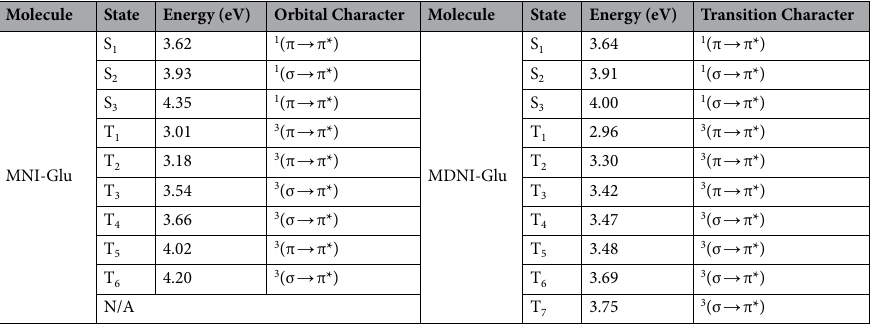
Table 2. Details of the excitation types for the singlet and triplet states in the experimental range (250– 500 nm) together with the excitation energy (in eV) for MNI-Glu and MDNI-Glu.